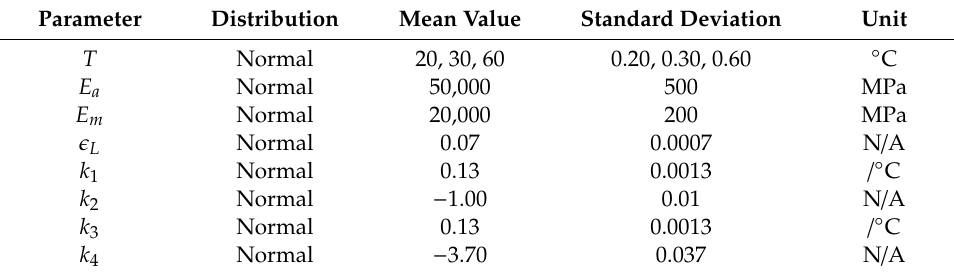
Table 3. Probability distribution of input